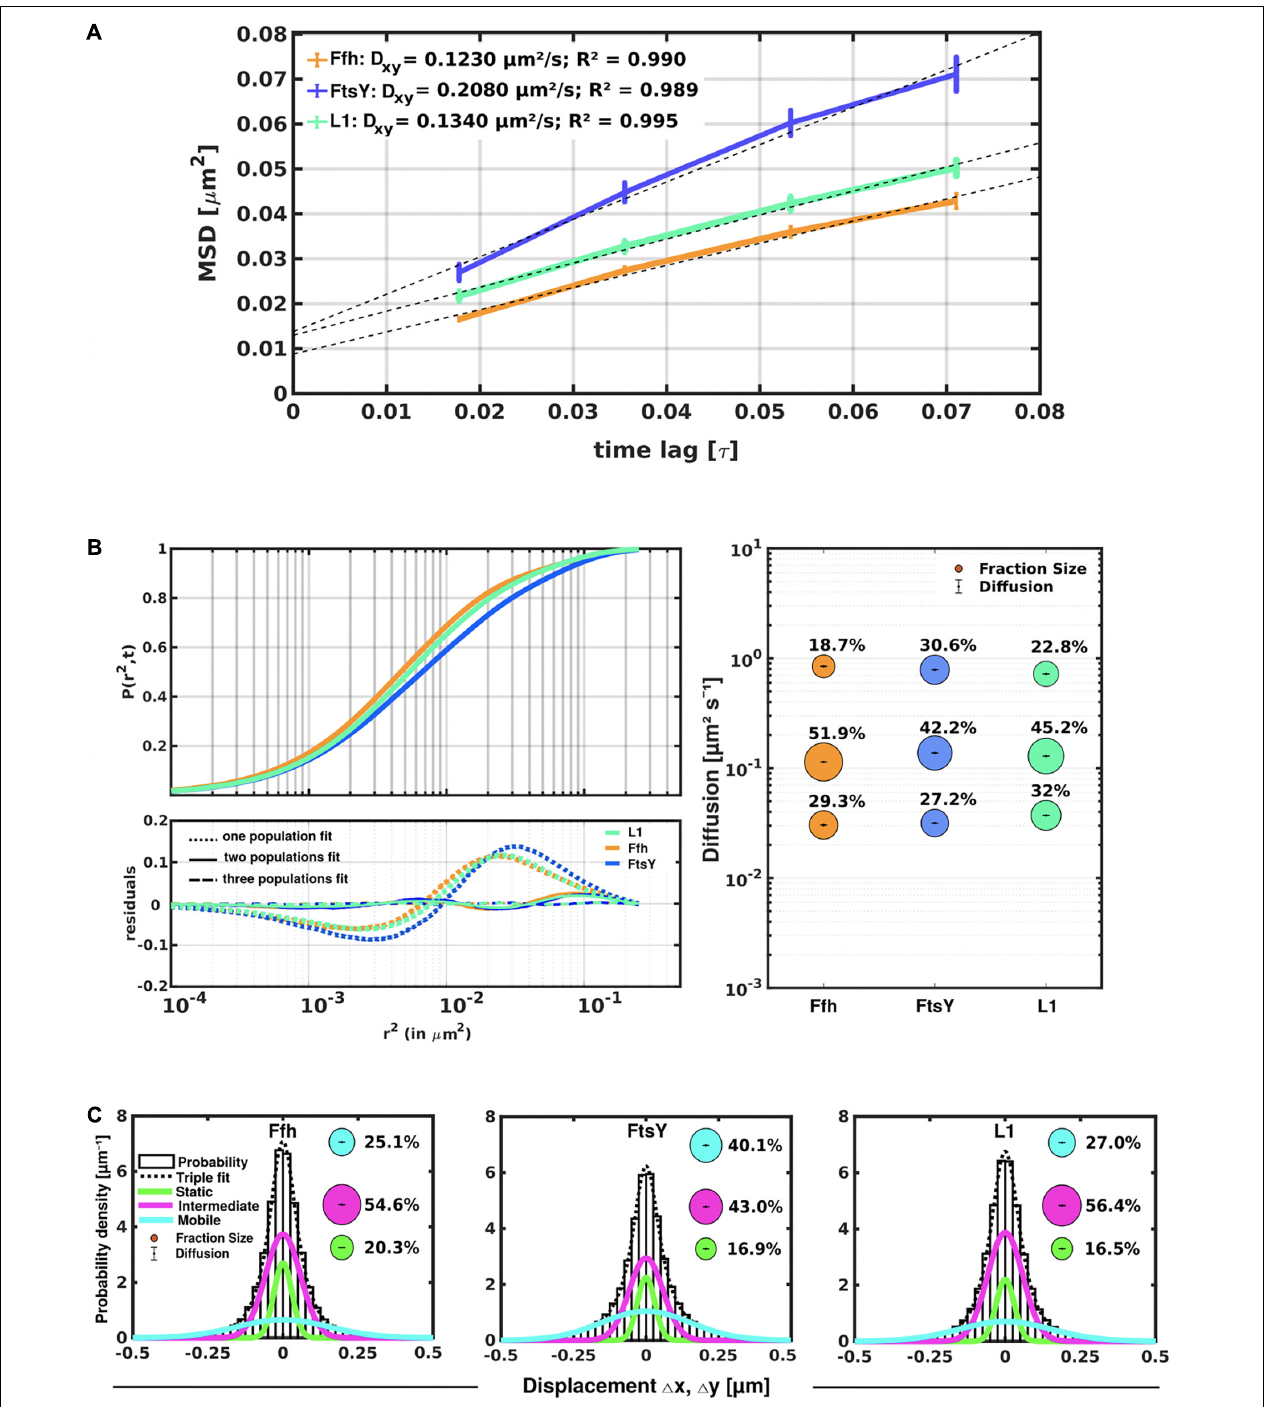
FIGURE 3 | Tracking of SRP, FtsY, and ribosomes in S. putrefaciens . (A) Mean squared displacement (MSD) analyses of Ffh-mVenus, FtsY-mVenus, and L1-mVenus (abbreviated “mV”), showing different overall diffusion constants, corresponding to each molecular weight. MSD assumes an overall diffusion regardless of subdiffusion. (B) Squared displacement (SQD) analyses shows measured data, suggesting three significantly distinct diffusive subpopulations (upper panel). Residual analysis of SQD confirms three population assumption (lower panel): colored curves represent differences between measured data and modeled data (using Brownian motion), which are represented by the “zero” line. Right panel shows a bubble blot, illustrating mean diffusion constants (y-axis) of fractions indicated as circles, with sizes corresponding to fraction size (also written above the circle). (C) Gaussian mixture model (GMM) analyses also identify three significantly distinct diffusive subpopulations at steady-state. Bubbles illustrate fraction sizes, with fractions indicated by the different colored lines. Dashed line indicates sum of the three GMM fits.